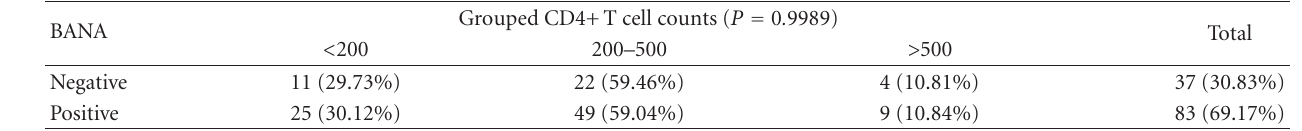
Table 2: Grouped CD4+T cell counts relative to